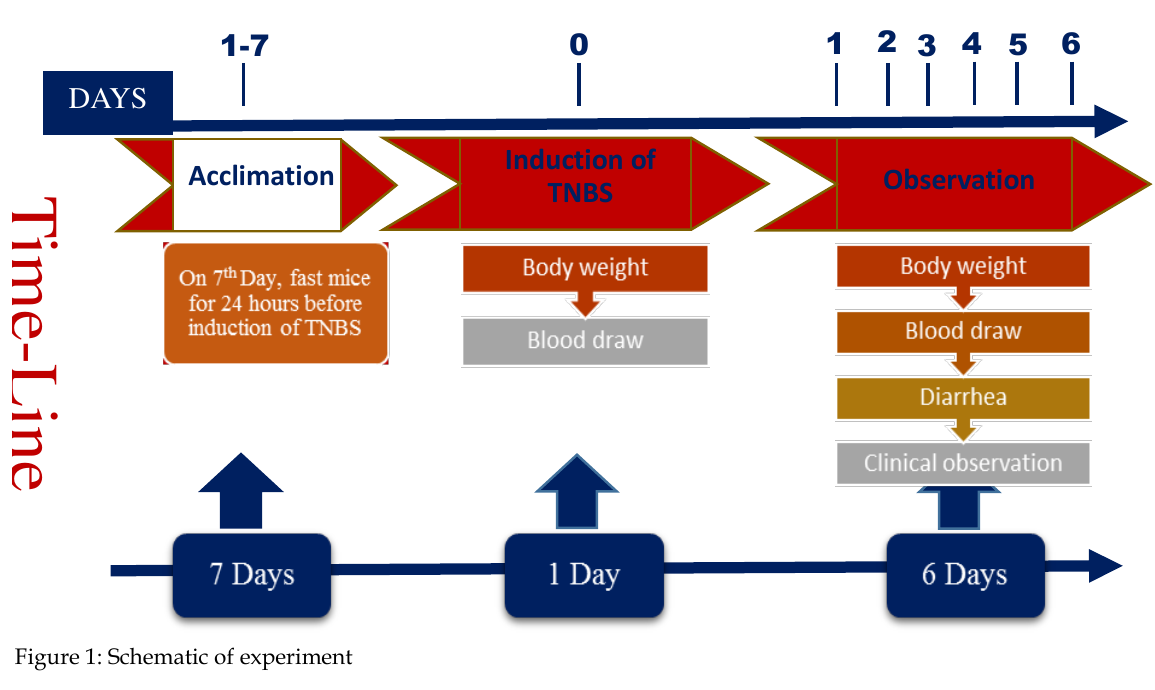
Figure 1: Schematic of experiment